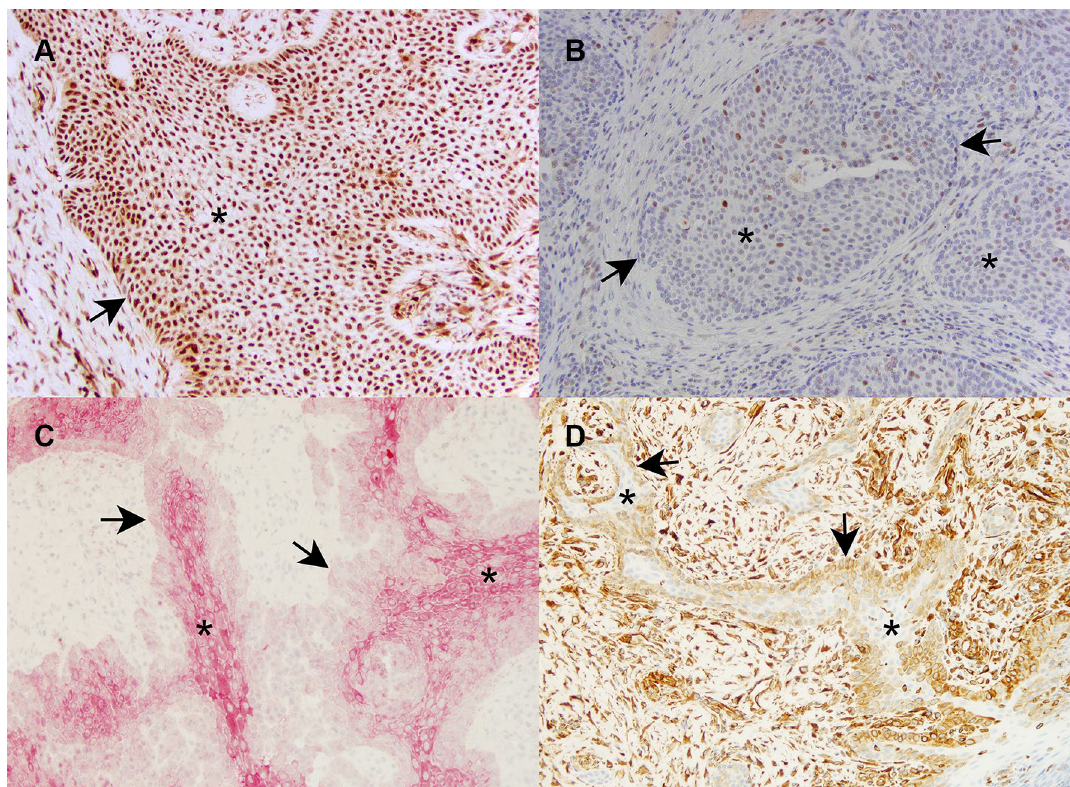
Figure 5. Immunohistochemical validation of MAPK pathway activation and EMT. The asterisks indicate neoplastic cells and the arrows indicate tumor margins. Panels ( A ) and ( B ) are representative photomicrographs of pERK1/2 in CAA (panel A , case 15) and COSCC (panel B , case 22). Strong and diffuse intranuclear immunolabeling in the neoplastic cells are present in CAA with similar labeling present in stromal cells ( A ). In COSCC, multifocal intranuclear labeling is present in the neoplastic cells at more variable intensity levels ( B ). Panels ( C ) and ( D ) are representative photomicrographs of CK (panel C , case 4) and VIM (panel D , case 2) immunoreactivity of CAA (IHC, 20X original magnification). Note a gradual increase in cytoplasmic CK expression of epithelial cells from the periphery to the center of neoplastic islands, while the mesenchymal